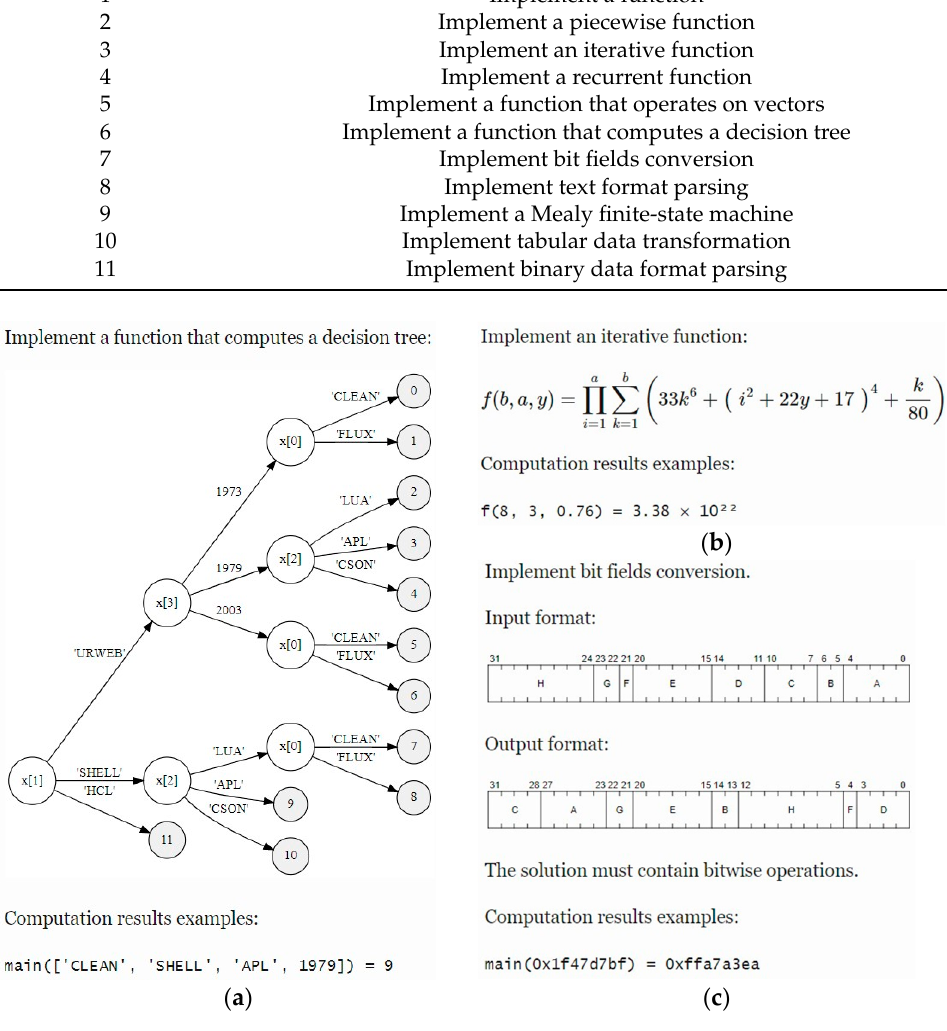
Figure 1. Examples of formulations for unique programming tasks of various types (see Table 1) automatically generated [6] by the DTA system [9,10]: ( a ) implement a decision tree, ( b ) implement an iterative function, ( c ) implement bit fields conversion.